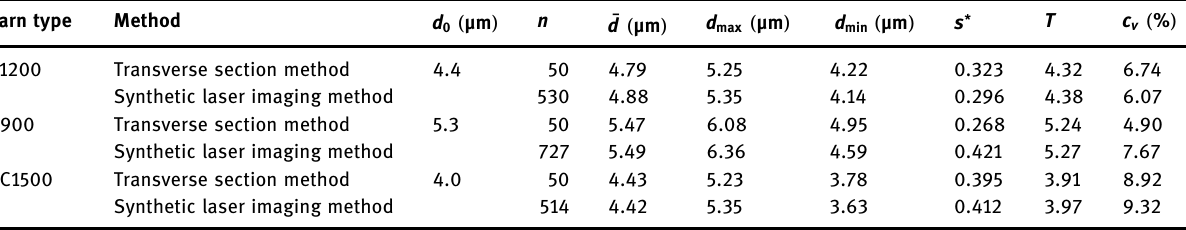
Table 1: Mono fi lament diameter statistics of three types of yarns Yarn type